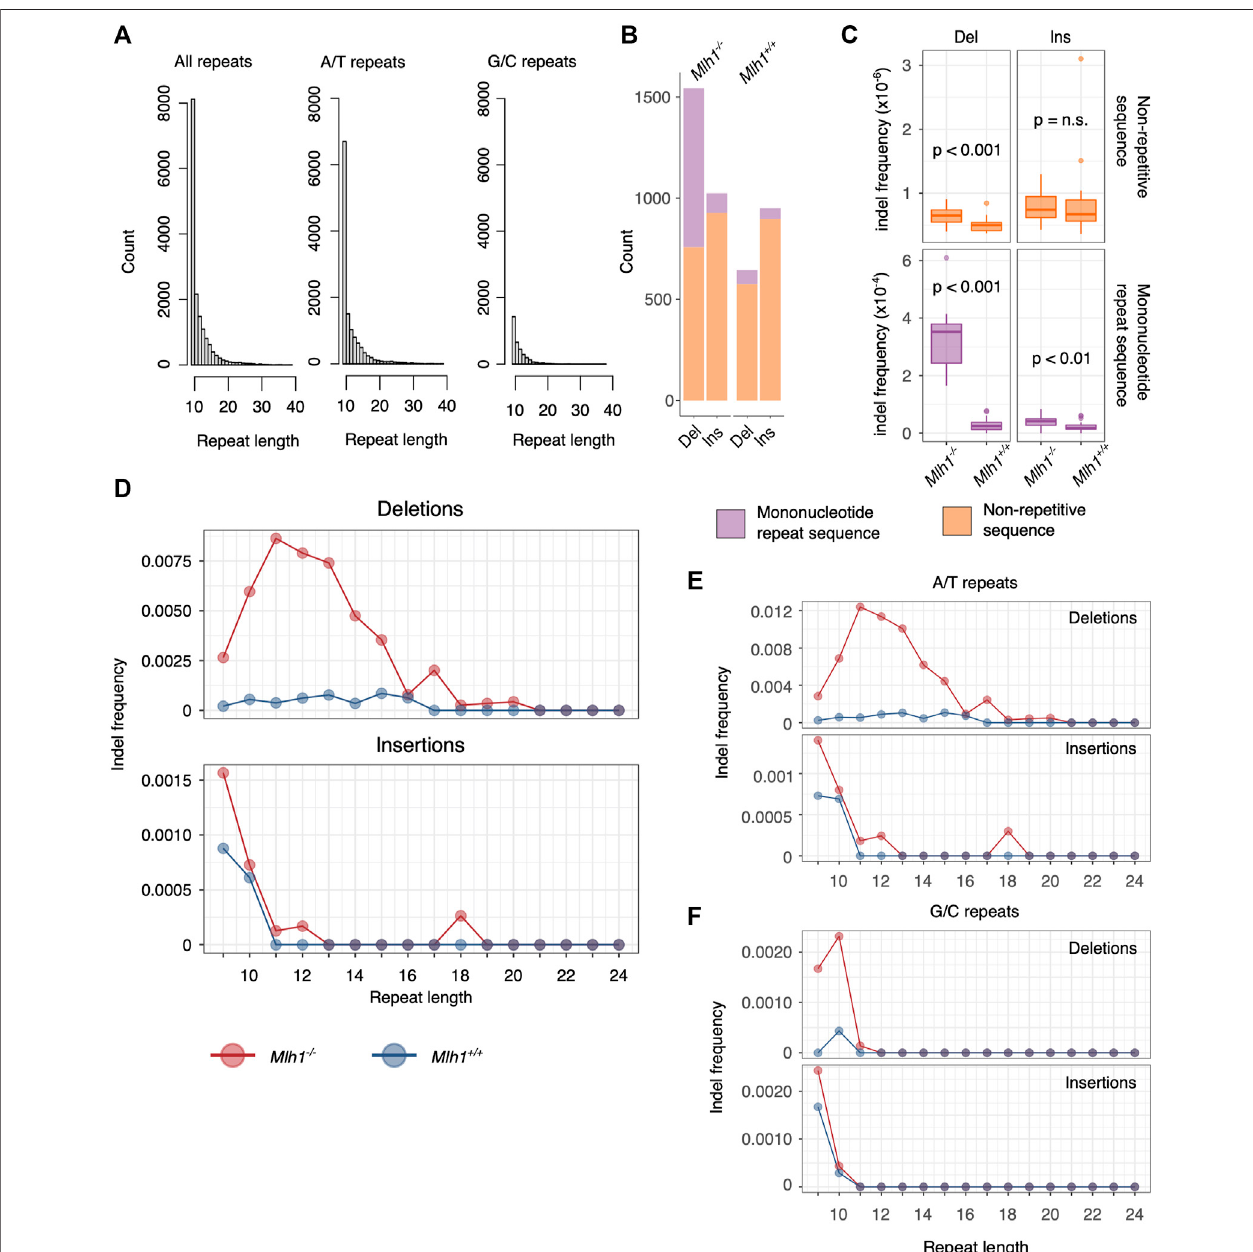
FIGURE 1 | Deletions accumulate to 10 – 14 nucleotides long mononucleotide microsatellites. (A) Length distribution of mononucleotide microsatellites in the mouse exome. Shorter A/T repeats account for the majority of mononucleotide repeats. (B) Number of de novo mutations in mononucleotide repeats of length 9 – 24 nt versus non-repetitive sequences (all sequences that do not ful fi ll our criteria of a mononucleotide repeat). More Mlh1 − / − deletions mapped to mononucleotide repeats than tonon-repetitive sequences, whereas insertions weremainly foundwithin non-repetitive sequences. In Mlh1 +/+ cells, themajorityofindels accumulate innon- repetitive sequences. (C) Deletion and insertion frequencies in mononucleotide repeats were signi fi cantly higher in Mlh1 − / − cells compared to Mlh1 +/+ cells, as was the deletion frequency within non-repeat associated sequences. Within non-repetitive sequences, no difference in insertion frequency was observed between Mlh1 − / − and Mlh1 +/+ cells. p values from two-tailed Mann-Whitney U-test. (D) Indel frequencies at mononucleotide repeats of different lengths. 10 – 14 nt long mononucleotide microsatellitesaccumulateddeletionsin Mlh1 − / − cellsbutnotin Mlh1 +/+ cells.Insertionsweremainlyfoundinmononucleotiderepeatsof < 11 ntlengthinbothgenotypes. (E – F) Indel frequency in A/T and G/C repeats. A/T repeats of length 10 – 14 nt long showed increased deletion burden in Mlh1 − / − cells compared to Mlh1 +/+ cells. In E, note the different scales for deletion vs insertion frequencies. G/C repeats behaved visibly differently than A/T repeats, with increased deletion and insertion frequency in short repeats ( < 11